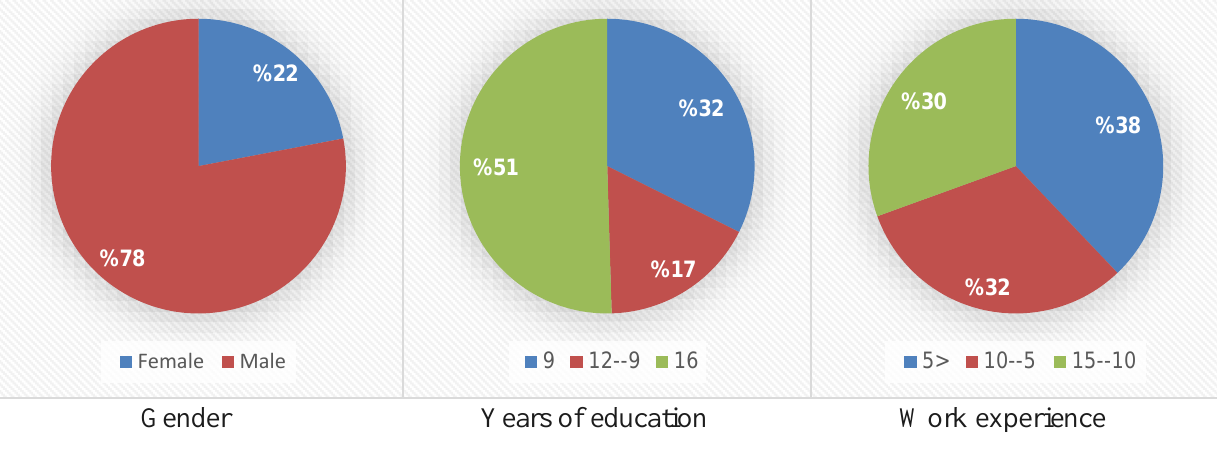
Fig. 2. Personal characteristics of the